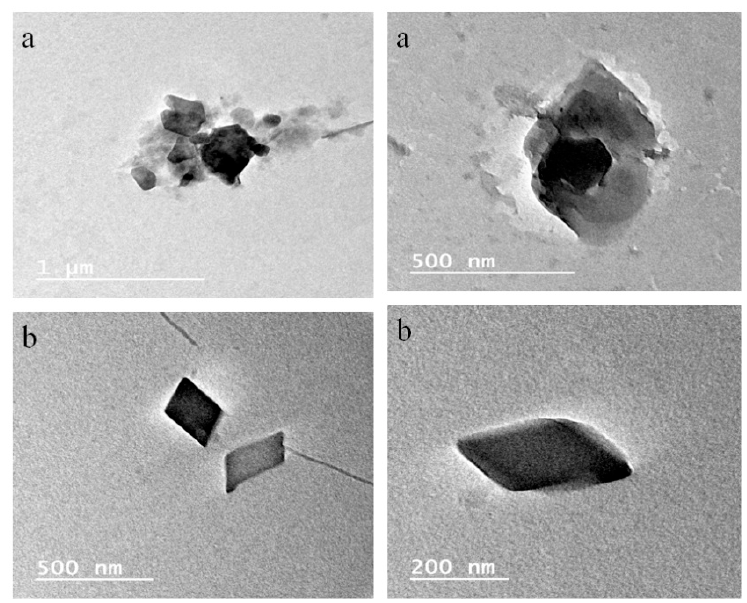
Figure 9. TEM images of ( a ) blank nanosponges and ( b ) BONS4.